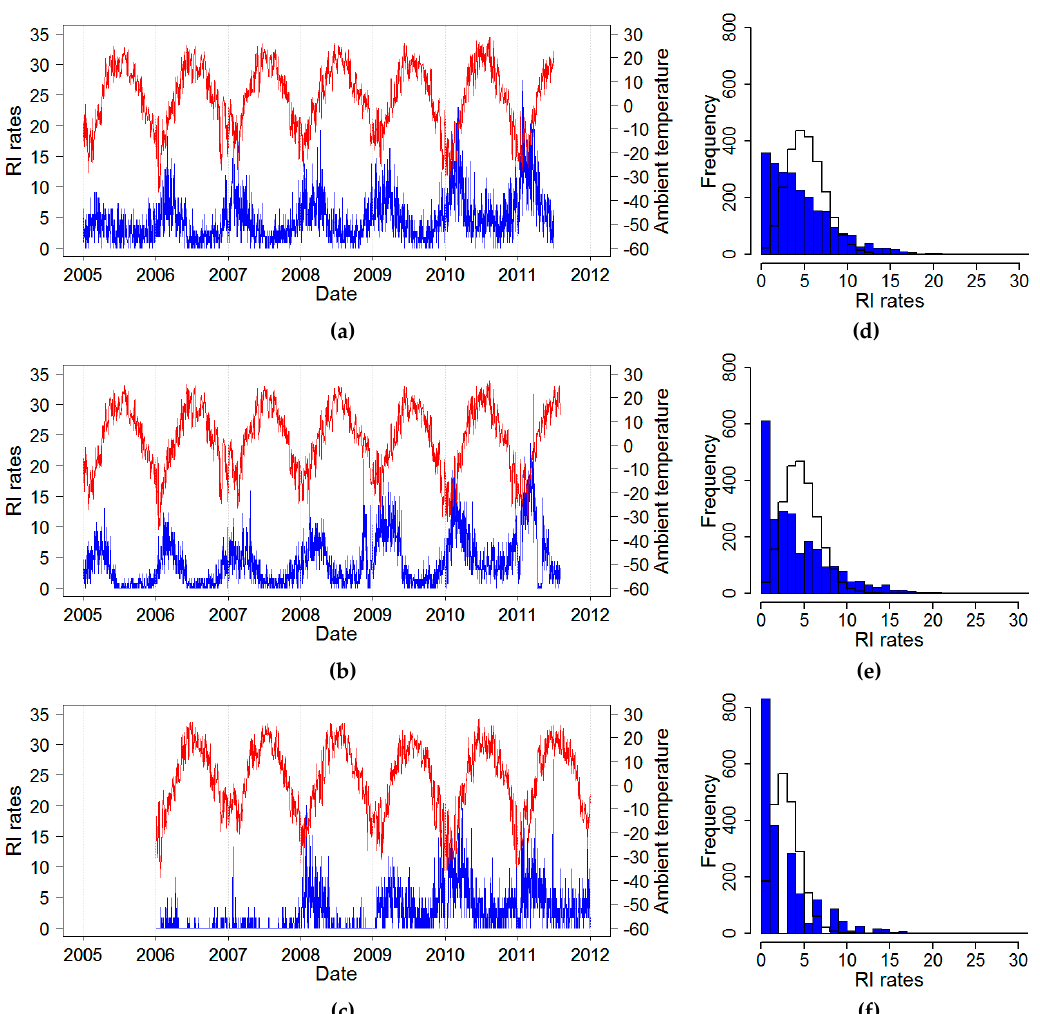
Figure 2. Time series of daily ambient temperature (red line) and daily rates of rotaviral infection (RI) (blue line) ( a – c ) along with the RI rate empirical distribution (blue color bars) and fitted Poisson distribution (black line) ( d – f ): ( a , d ) Chelyabinsk; ( b , e ) Yekaterinburg; and ( c , f ) Barnaul, Russia, 2005-2011.